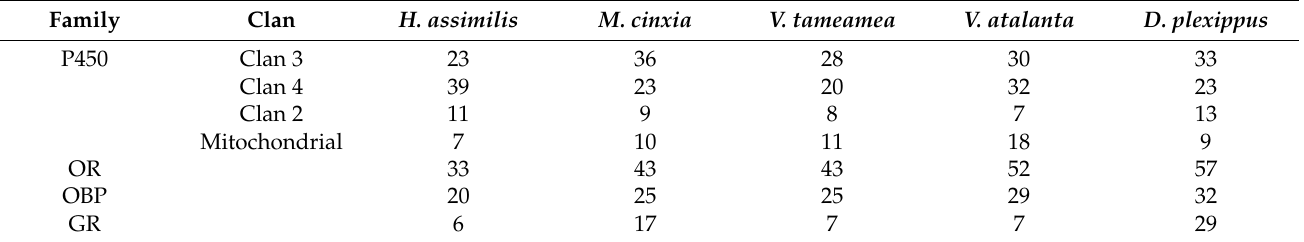
Table 1. Comparison of detoxification and chemosensory gene families between the saprophagous butterfly H. assimilis, M. cinxia, V. tameamea , and V. atalanta , and the nectarivorous D. plexippus